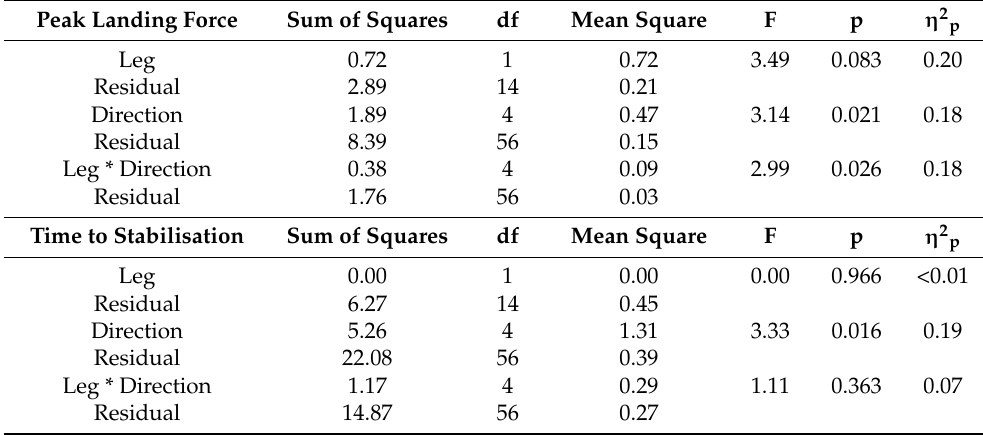
Table 2. Two-way repeated measures ANOVA for peak landing force and